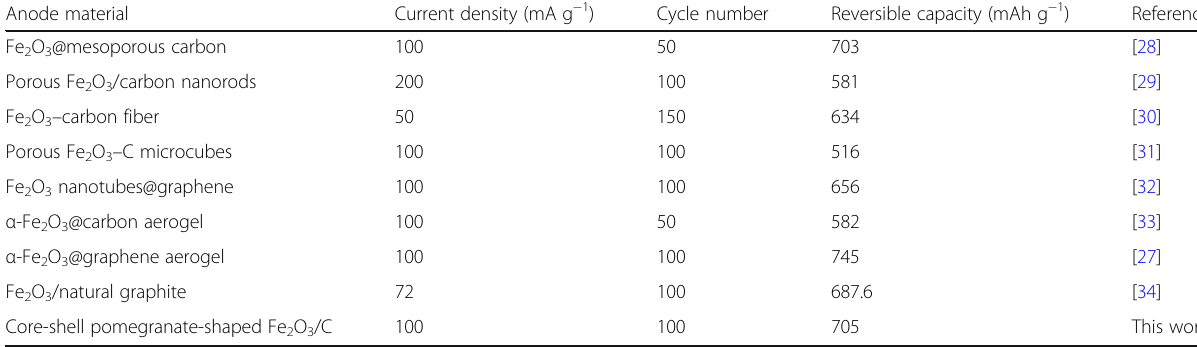
Table 1 The comparison of Li storage performances between this work and the previous literature Anode